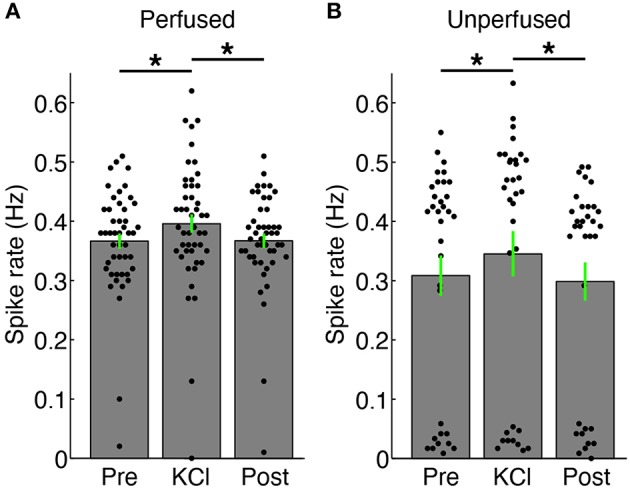
Changes in firing rate with addition of 20 mM KCl. (A) Spikes were recorded via substrate electrodes from a perfused 3-D cell culture for a baseline period (“Pre”), with 20 mM KCl medium applied to the surface of the culture, and after a 5X washout of the KCl (“Post”). Each black dot represents the mean spike detection rate on a single electrode. The gray bars are the spike rates averaged over all channels ± SEM. The firing rate of the culture increased upon introduction of KCl solution (*P < 0.05, paired t-test, N = 47 electrodes). (B) Spike rates from an unperfused 3-D cell culture recorded under identical conditions as in (A). There were more channels with lower spiking rates in the unperfused culture, and in particular many more channels without active neurons (dots below 0.1 Hz), but the culture also increased its firing compared to baseline (“Pre”) and after washout (“Post”) conditions (*P < 0.05, paired t-test, N = 33 electrodes). There was no significant difference in firing rates between the Pre and Post periods in either case. Fluid was added in the same manner for the KCl and “Post” periods in both perfused and unperfused cultures.